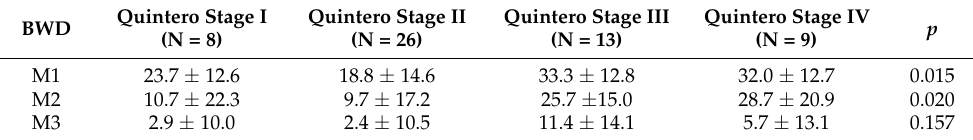
Table 2. The BWDs at M1, M2, and M3 according to Quintero stage.